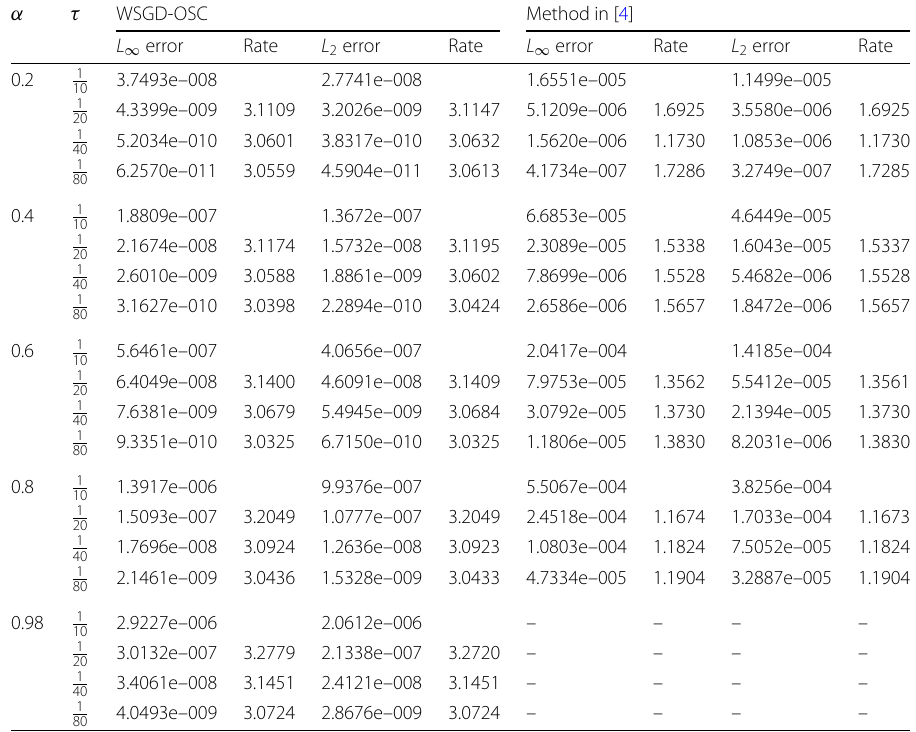
Table 7 The L ∞ , L 2 errors and temporal convergence order with h = 1/1000 for Example 4